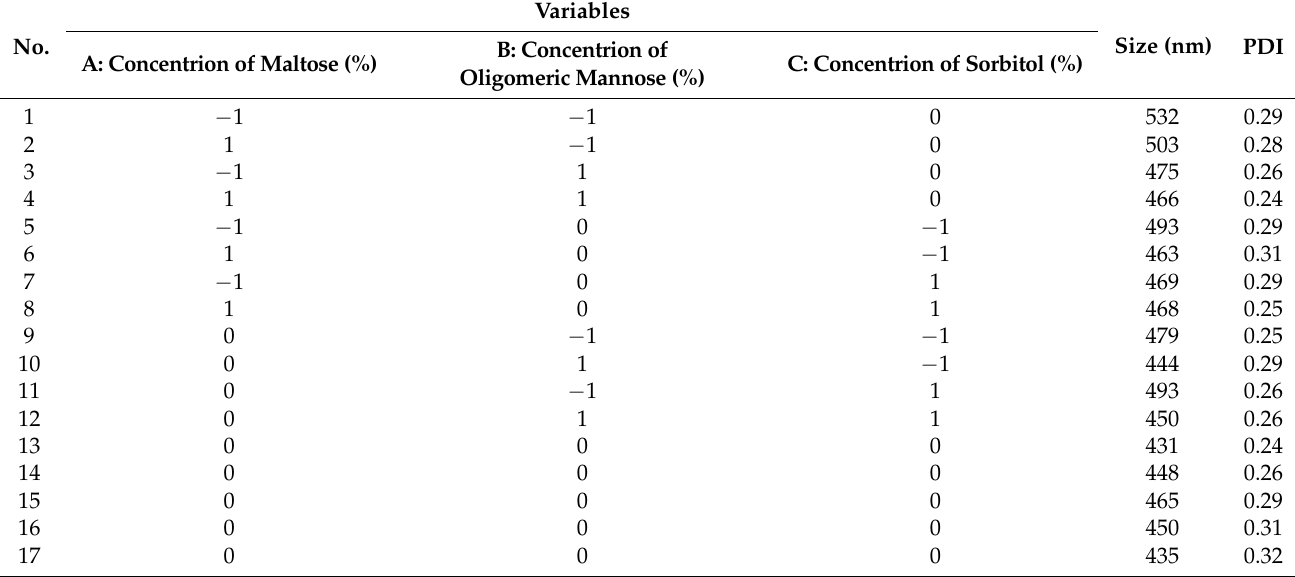
Table 1. Box–Behnken factorial design (BBD) of three variables and response